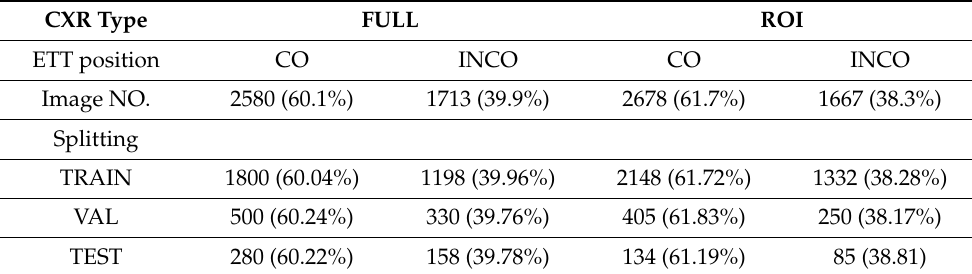
Table 1. Total number of CXR images and distribution of data in this